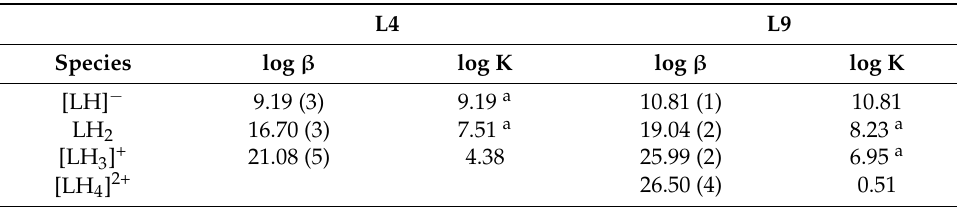
Table 1. Protonation constants of L4 and L9 ligands evaluated from potentiometric titration at 25 ◦ C and 0.1 NaCl ionic strength. L indicates the completely deprotonated form of the L4 and L9 ligands.